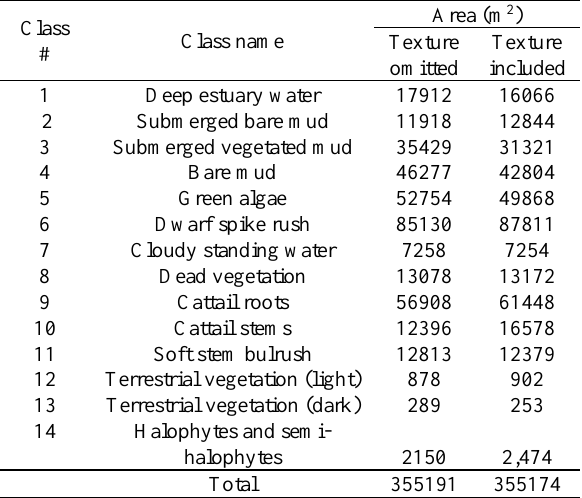
Figure 4. Classified image of the Musquash restoration site produced with the Random Forest classifier applied to (a) 38 spectral bands and vegetation indices, and (b) 138 spectral bands, vegetation indices, and textural features of the UAV imagery. Table. 7. Area of each landcover class extracted from the classified